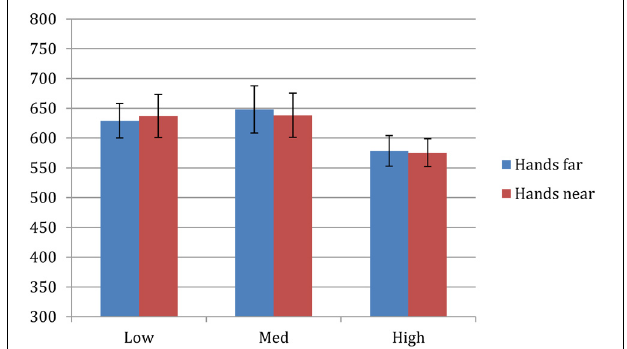
FIGURE 3 | Experiment 2 results. There was a main effect of pitch ( F = 6.712, p = 0 . 003), but no significant effect for hand proximity ( F = 0 . 009, p = 0 . 926) or interaction between hand proximity and pitch ( F = 0 . 215, p = 0 .